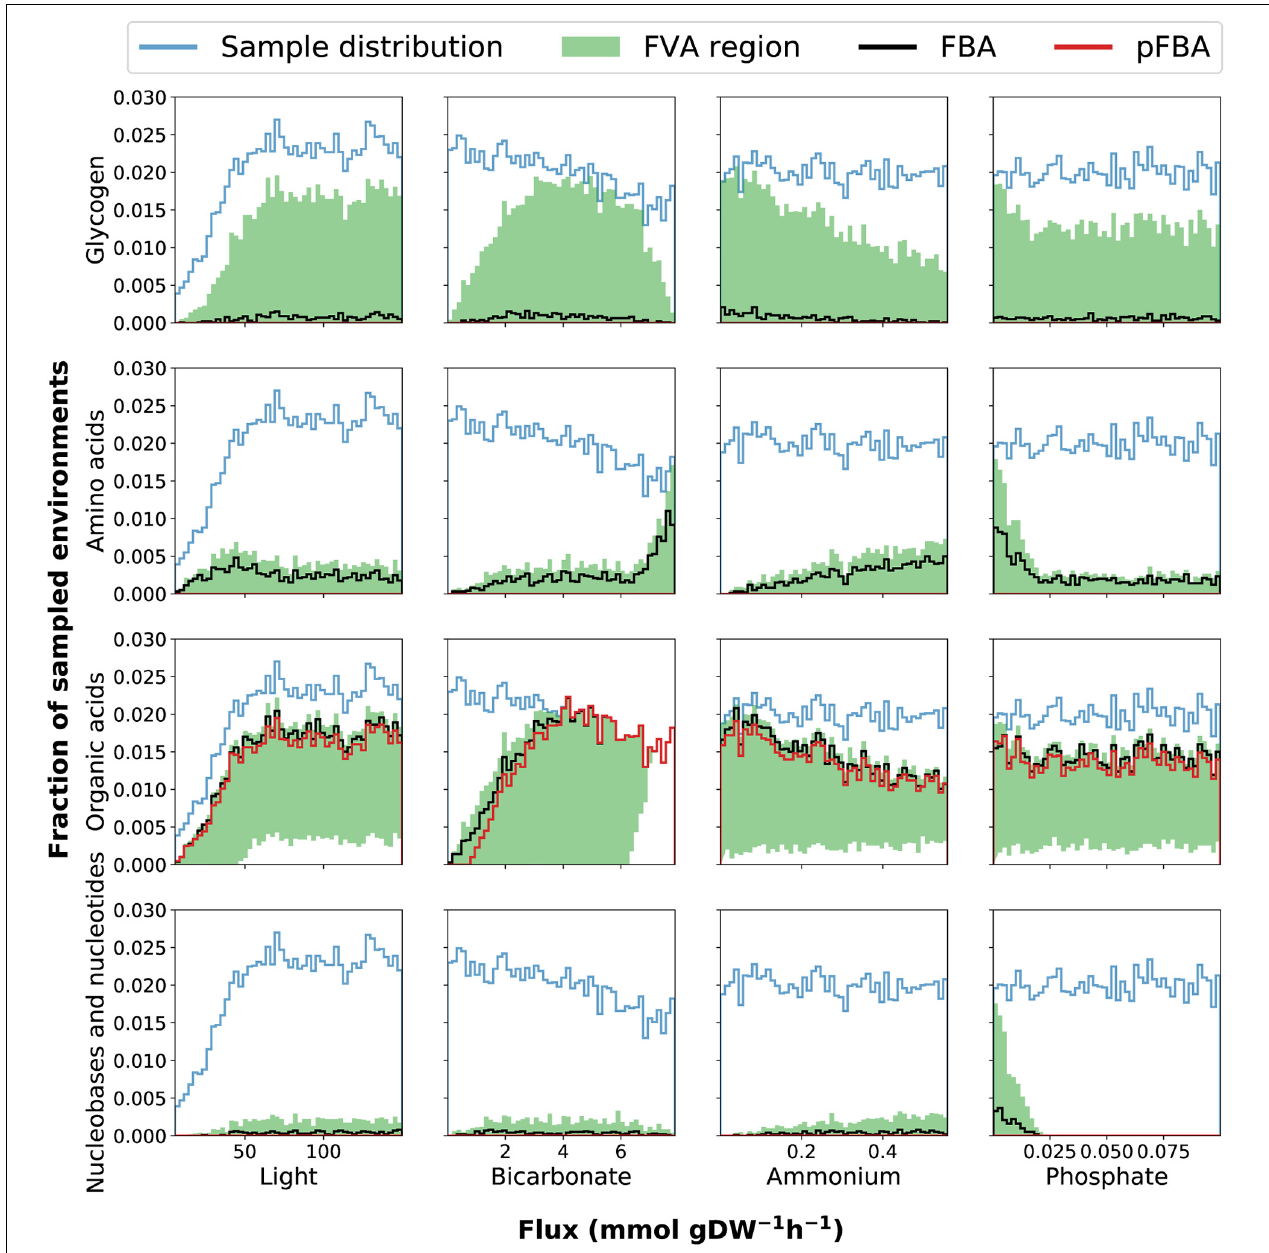
FIGURE 3 | Histograms of environmental sampling results provide insight into how the fixed uptake rates of light and bicarbonate and the upper bounds on ammonium and phosphate affect exudation of organic acids, nucleobases and nucleotides, amino acids as well as glycogen storage. The y -axis represents the fraction of all sampled environments yielding feasible models. Although we initially sample each parameter uniformly the final sample distribution is not uniform because some combinations of parameters represent infeasible phenotypes (no solution can satisfy the constraints). The final sample distribution for each parameter is therefore shown in the figure panels as a blue line. The black and red lines represent the histograms of samples where exudation is predicted by FBA and pFBA, respectively. The shaded green region represents the span between histograms of samples as predicted by FVA: the lower and upper bounds represent the number of samples where exudation is predicted using the minimum and maximum value of FVA, respectively. This FVA region covers the range of possible phenotypes. The lower bound of the FVA region displays the number of samples where a certain outcome is obligatory to maximize growth, while the upper bound of the FVA region displays the number of samples where the outcome is possible without reducing